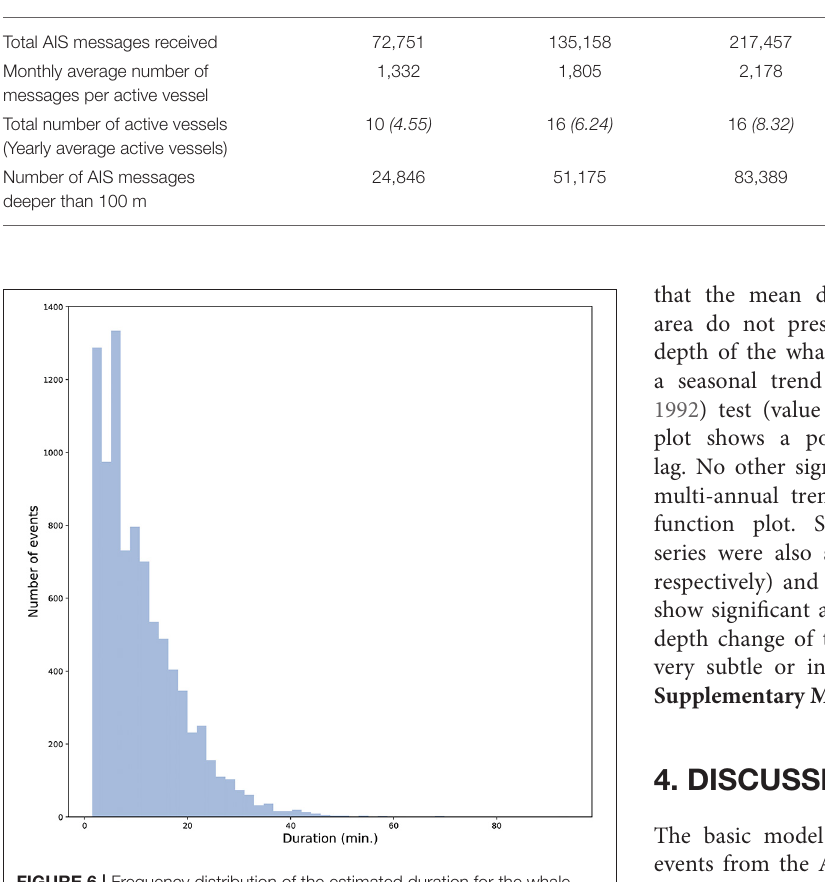
min (Pers. obs.) and falls within the maximum time allowance of 30 min established in the local whale watching regulations (Gobierno de Canarias,